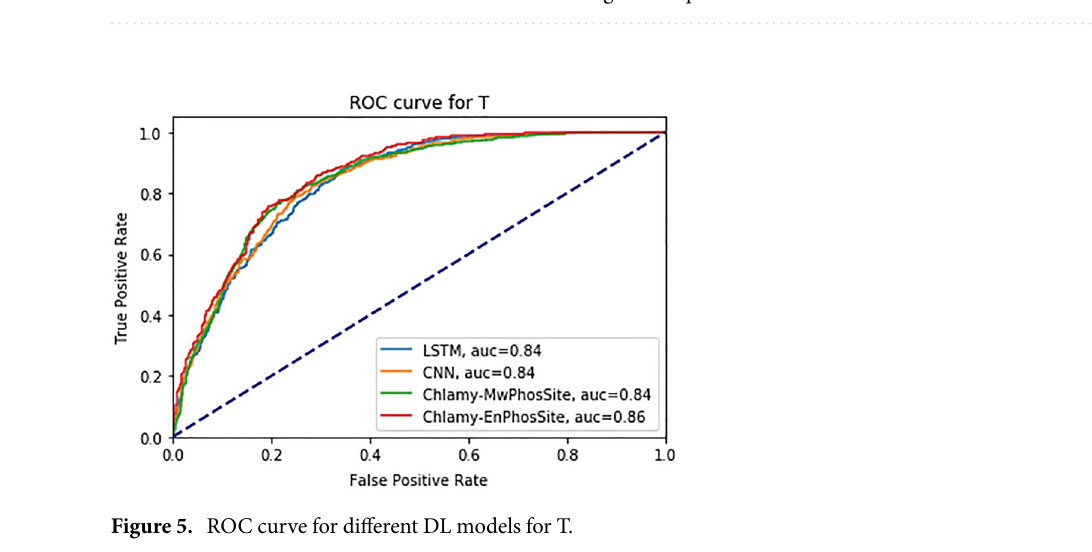
Table 7. Performance metrics of different models using an independent test dataset for T.